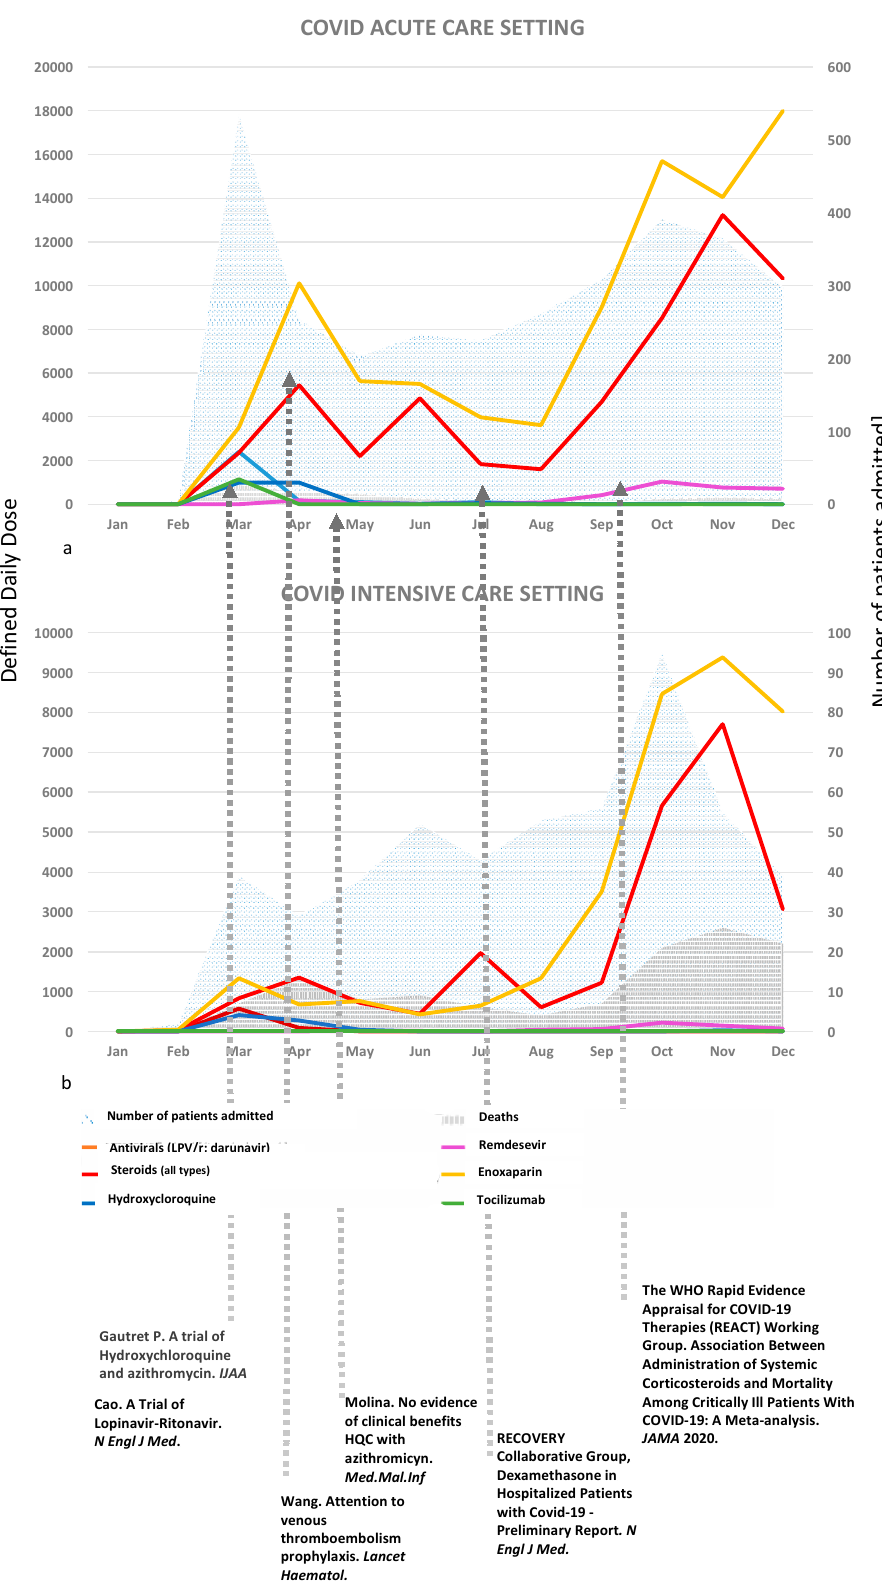
Figure 1. Admitted patients, deaths, and drug DDD trends in both ACS ( a ) and ICS ( b ) according to the emergence of relevant scientific data from January to December 2020.